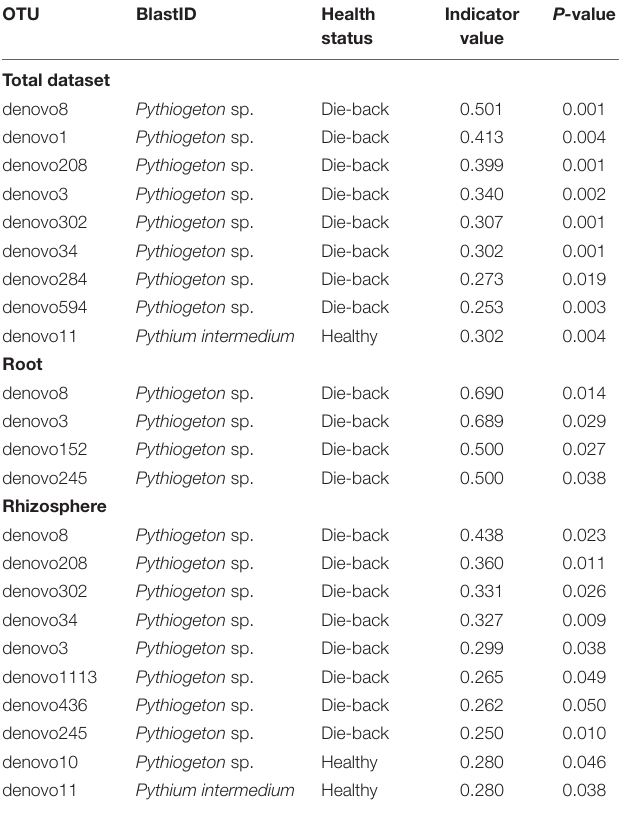
TABLE 3 | List of indicator species that were significantly different calculated using the Dufrene and Legendre analysis in R, considering the total dataset, only roots samples, and only rhizosphere samples.